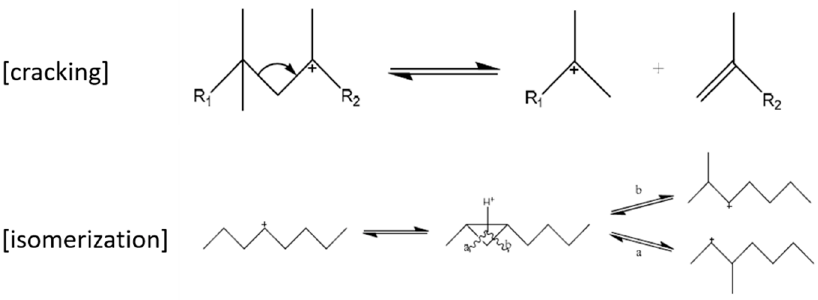
Figure 1. Mechanism of cracking and isomerization of n-paraffins